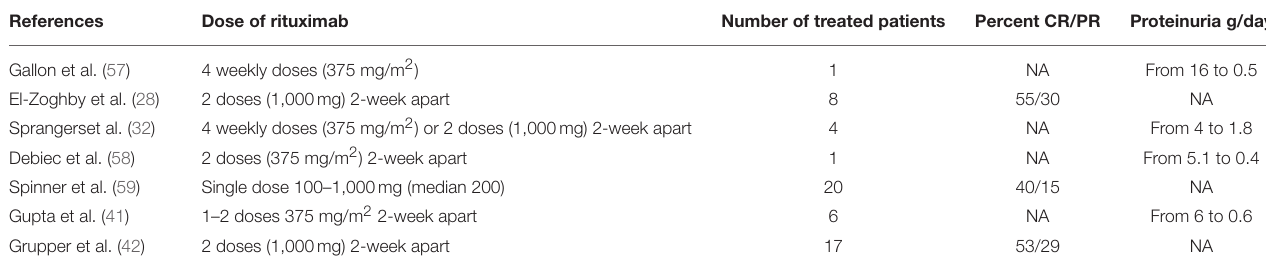
TABLE 2 | Results of treatment of recurrent MN with